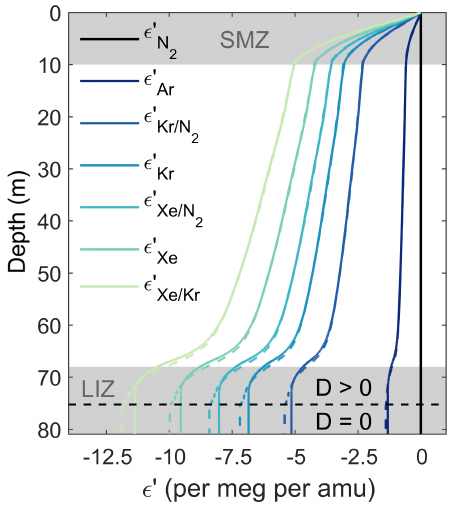
Figure 11. Horizontally averaged isotope ratios at WAIS Divide in the 2-D model including barometric pumping and horizontal lay- ers. Isotope ratios are normalized to one atomic mass unit (amu) mass difference (Supplement). The dashed black line represents the equilibrium solution for pure gravitational settling ( δ grav ). The hor- izontal blue line marks the depth where vertical diffusivity reaches zero. Observed δ 15 N are shown as circles with horizontal error bars (Battle et al., 2011). The inset shows a magnification of the lock-in zone (gray patch).